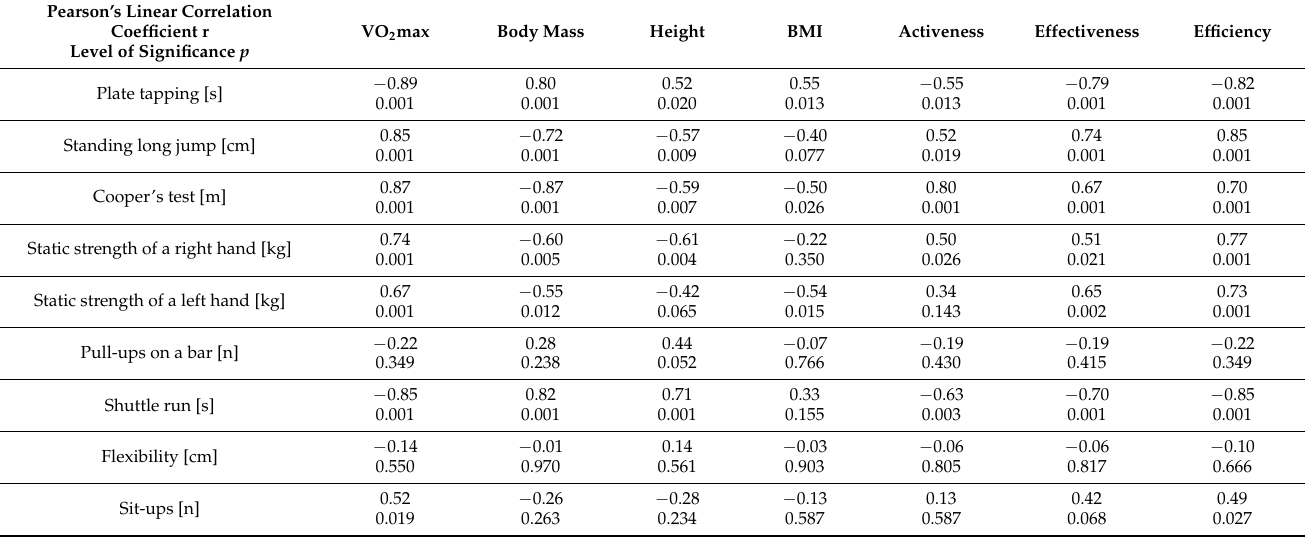
Table 5. The influence of selected variables on the results of fitness tests.